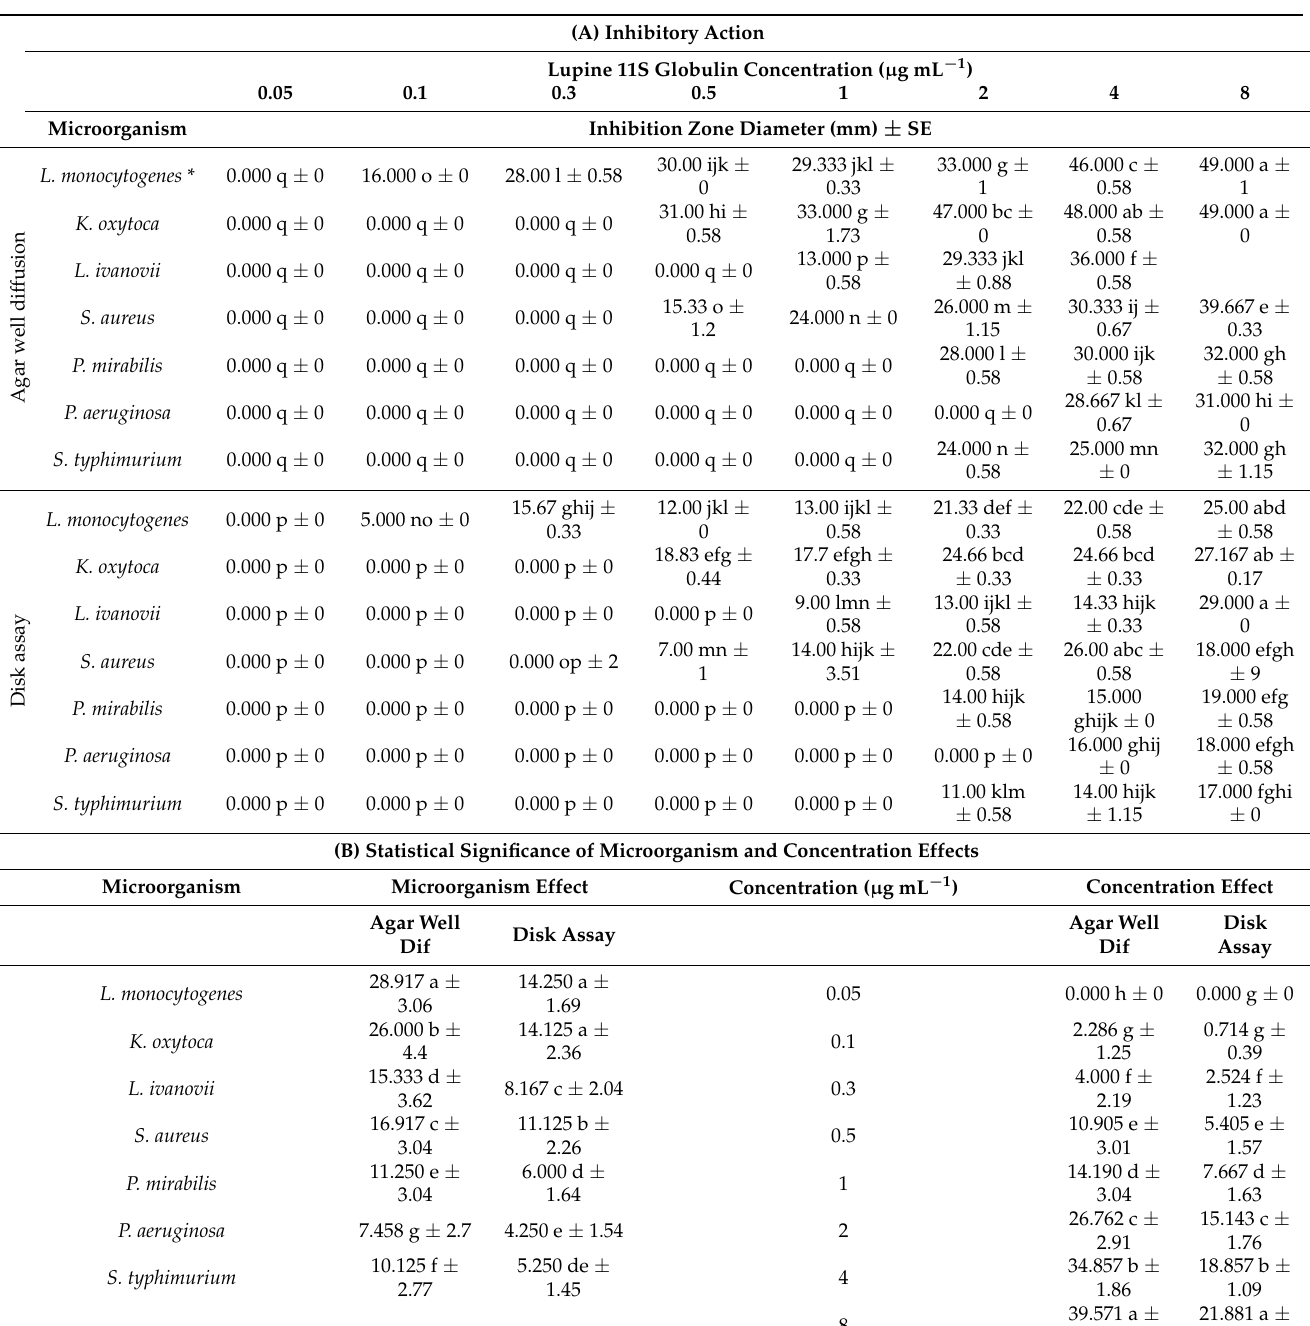
Table 1. Bacterial inhibitory actions of graded concentrations of lupine 11S globulin using agar well diffusion and disk assay techniques ( A ) and statistical significance ( B